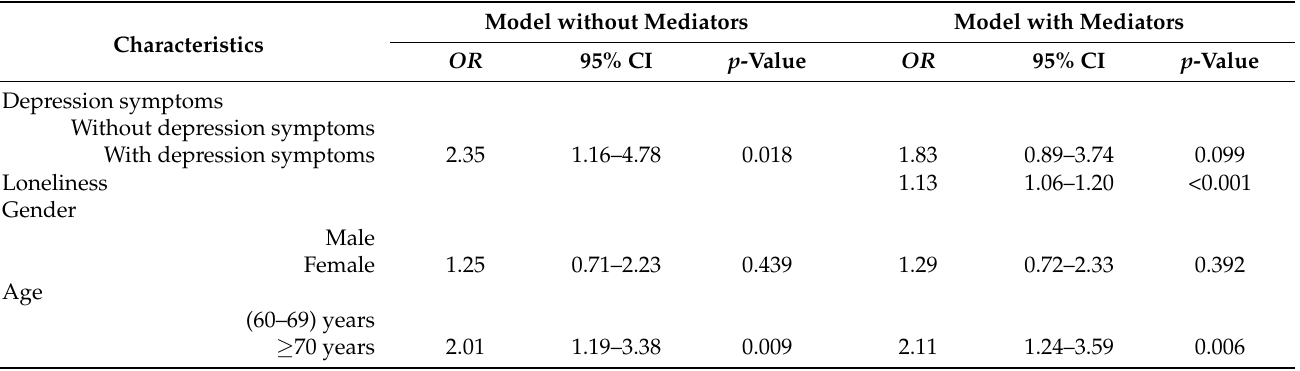
Table 3. The mediating effect of loneliness on the relationship between depressive symptoms and cognitive frailty ( n =